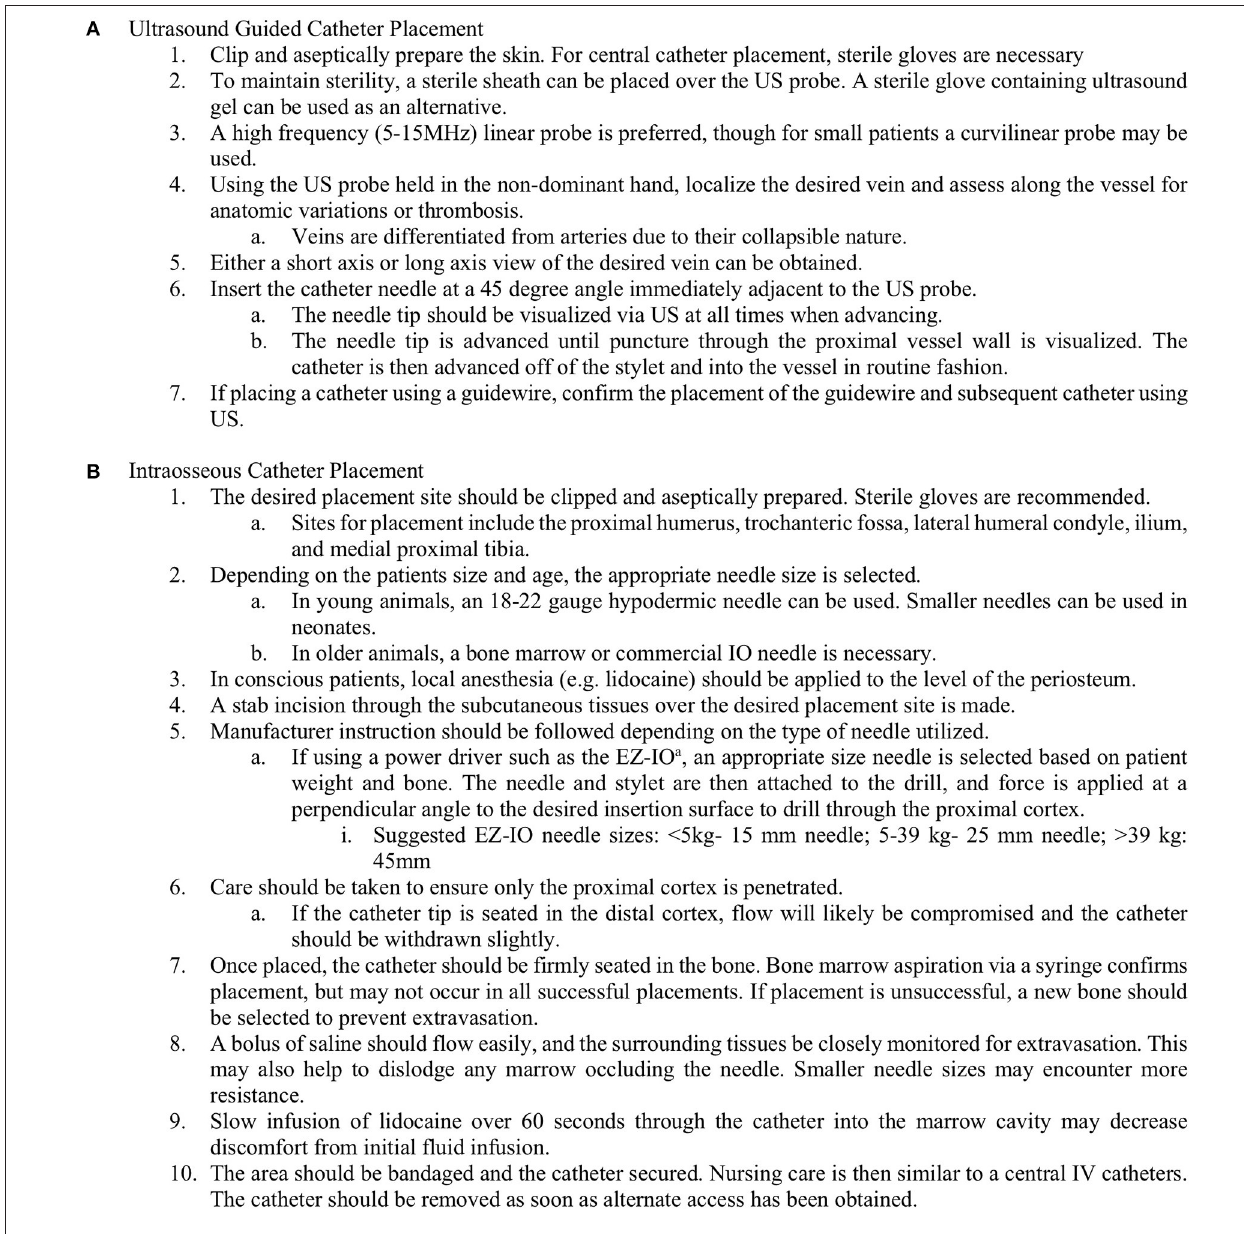
FIGURE 1 | Procedure for ultrasound-guided catheter placement (A) and intraosseous catheter placement (B) in dogs and cats in order to obtain emergency vascular